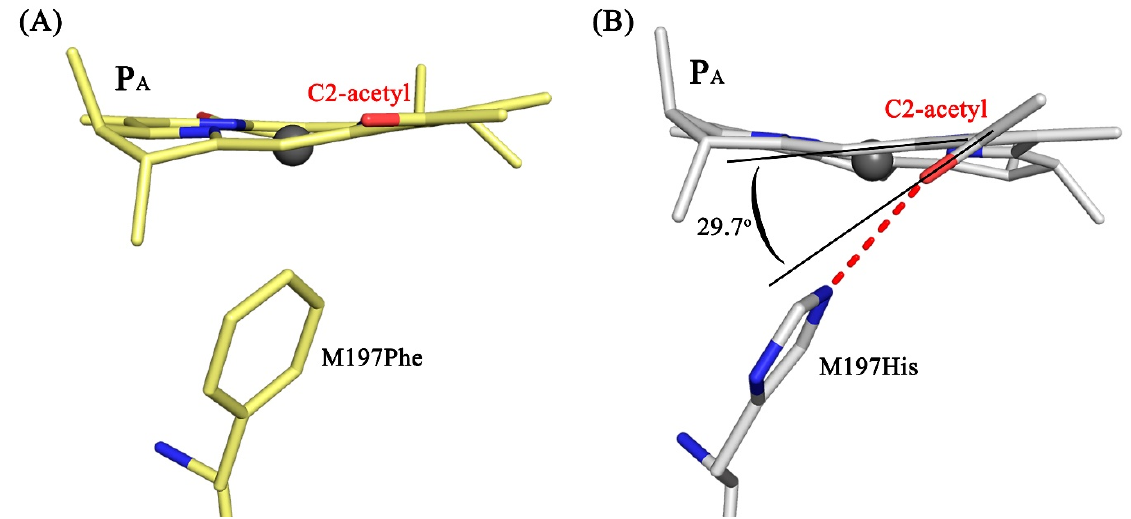
Figure 5. Position of the C2-acetyl group of BChl P B in the structures of the wild-type RC (PDB ID: 3V3Y) ( A ) and RC I(L177)H + F(M197)H (PDB ID: 8C3F) ( B ). The view is along the BChl plane. Analysis of the RC I(L177)H + F(M197)H structure in the vicinity of P B (Figure 6) shows that the main pattern of the previously described H-bonding network, which cludes the C2-acetyl carbonyl group of BChl P B , the imidazole group of His-M197, side groups of Asn-M195, Ser-L158, Asp-L155, and Tyr-M198 and two water molecules (as-